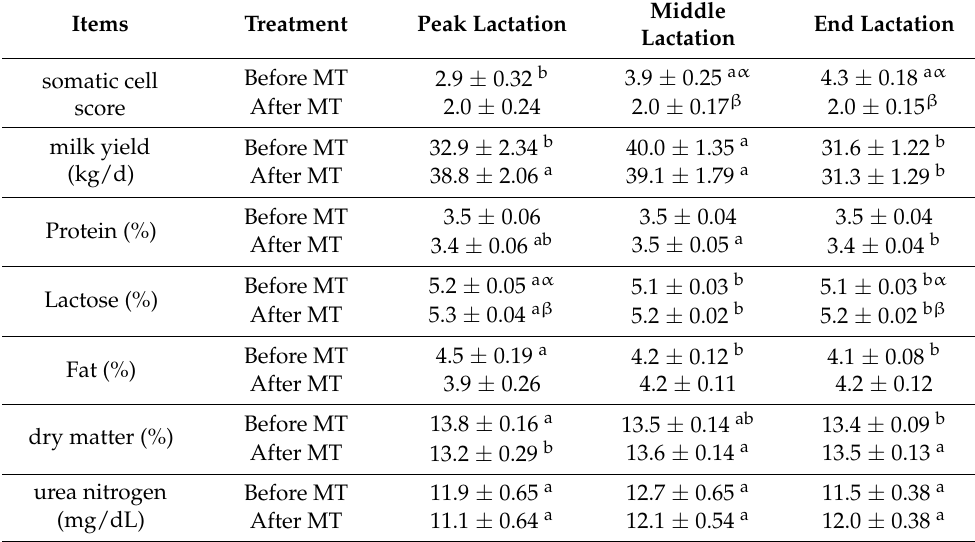
Table 7. Effects of melatonin on the DHI in cows with high SCS during different lactation